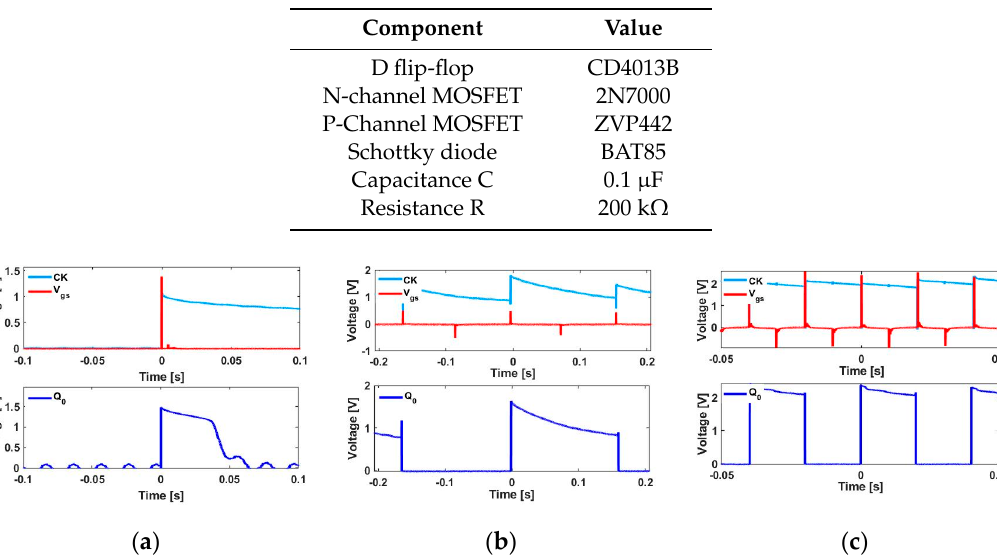
Figure 7. Proposed single-bit, self-powered counter with the active rectifier. Table 1. Circuit parameters: single-bit digital counter using the active rectifier.